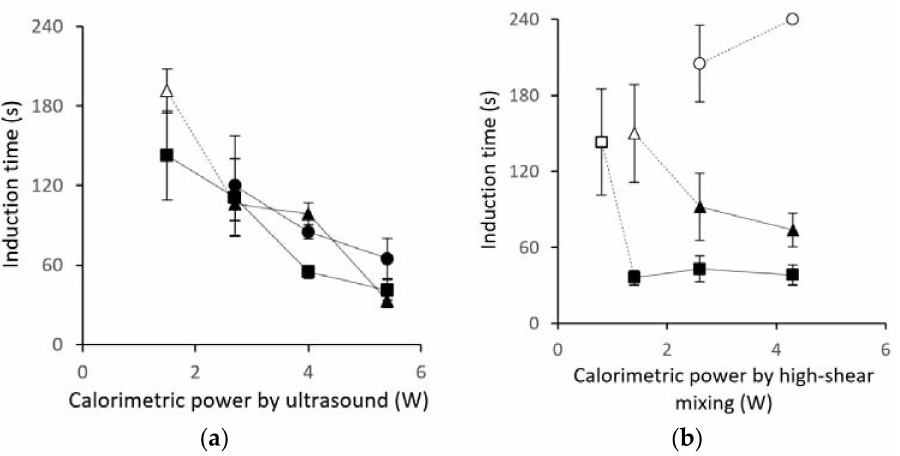
Figure 2. Induction time as a function of the applied calorimetric power at different supersaturation ratios (S = 1.14, ; S = 1.28, (cid:78) ; S = 1.39, (cid:4) ) for ( a ) the ultrasound probe, and ( b ) the rotor–stator mixer. Points marked in white ( , (cid:3) , (cid:52) ) had at least one measurement that exceeded the maximum measuring (cid:35) time of 240